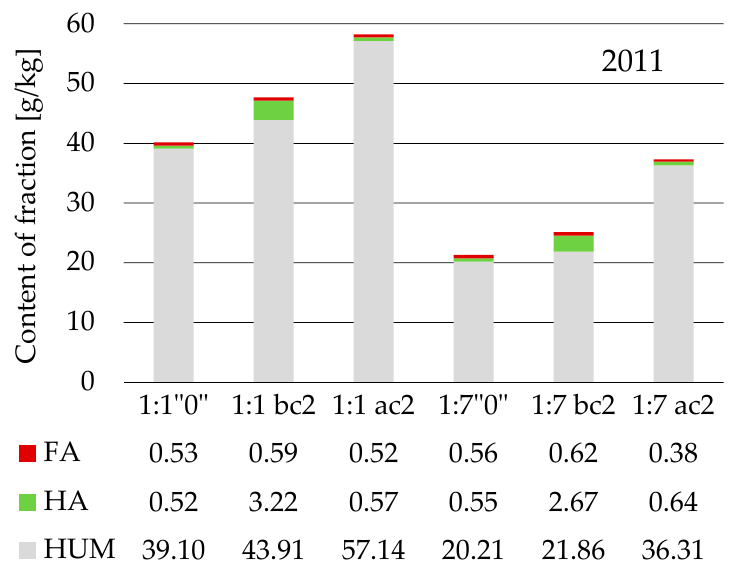
Figure 9. The content of humic substances in soils from pot experiment in 2011.